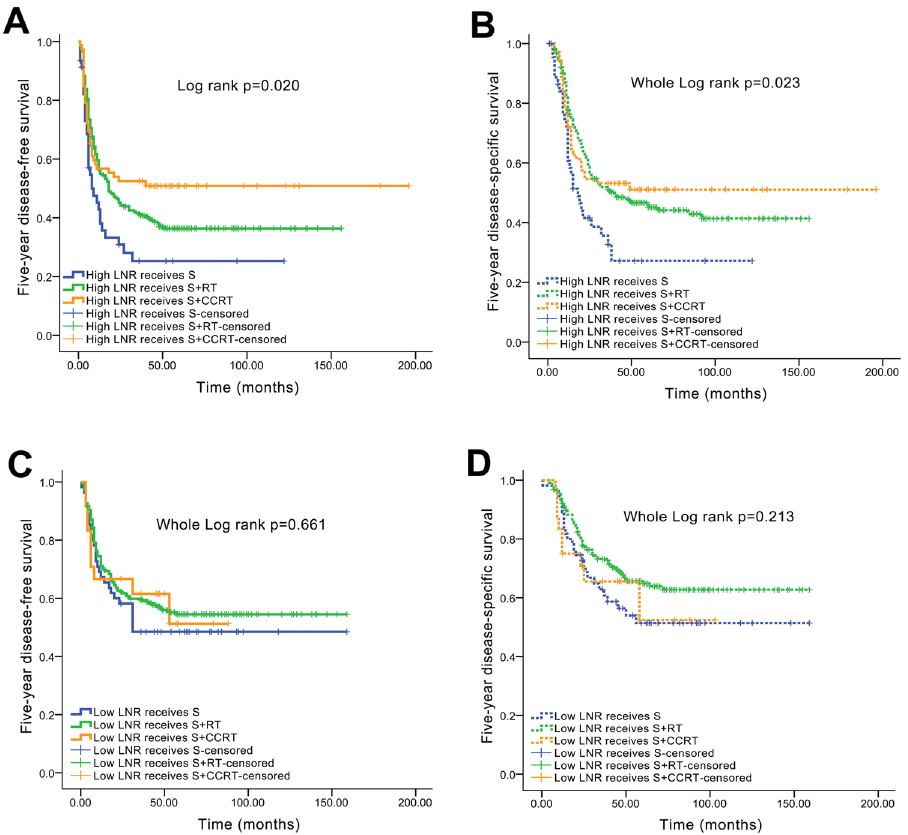
Figure 4. Kaplan-Meier analyses of 5-year DFS and DSS between the LNR and management. ( A ) Five-year DFS curves for patients with a high LNR who received surgery alone, surgery + RT, or surgery + CCRT; ( B ) 5-year DSS curves for patients with a high LNR who received surgery alone, surgery + RT, or surgery + CCRT; ( C ) 5-year DFS curves for patients with a low LNR who received surgery alone, surgery + RT, or surgery + CCRT;